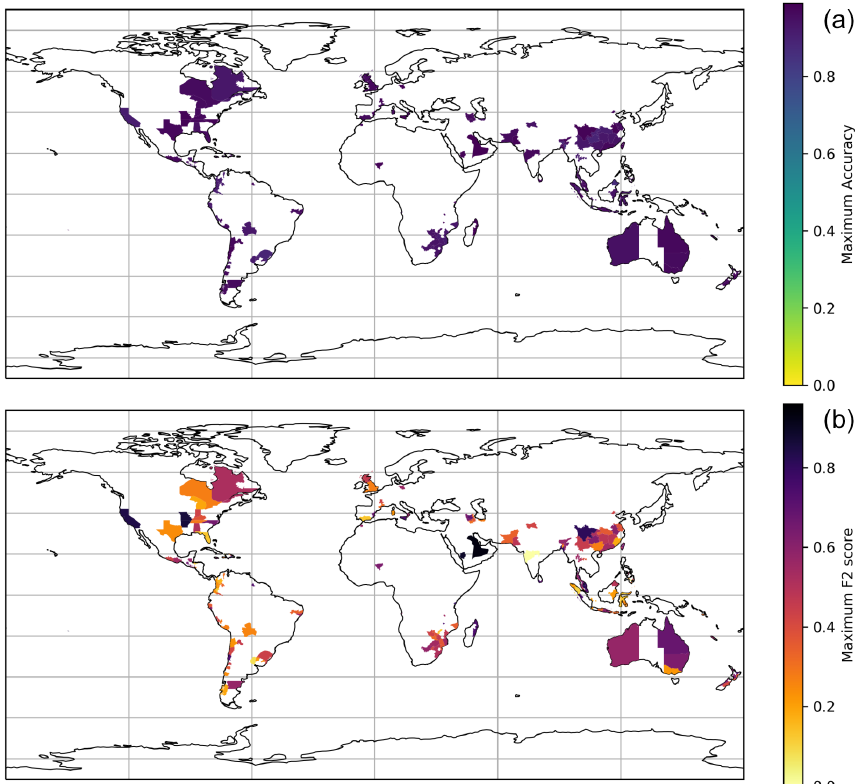
Figure 11. (a) Global map showing the average accuracy of true positives between filtered heavy rainfall tweet activity and events in the Met Office impact database for each GADM level 1 administrative area with an event recorded in the Met Office database during the period. (b) Global map showing the maximum F2 score of precision/recall between filtered heavy rainfall tweet activity and events in the Met Office impact database for each GADM level 1 administrative area with an event recorded in the Met Office database during the